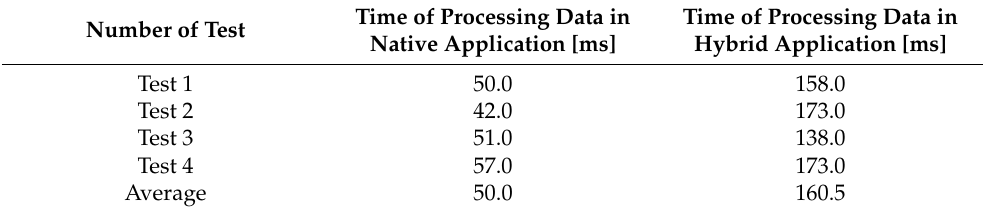
Table 5. Time taken to process the data from REST API (response with 50 objects). Number of Test